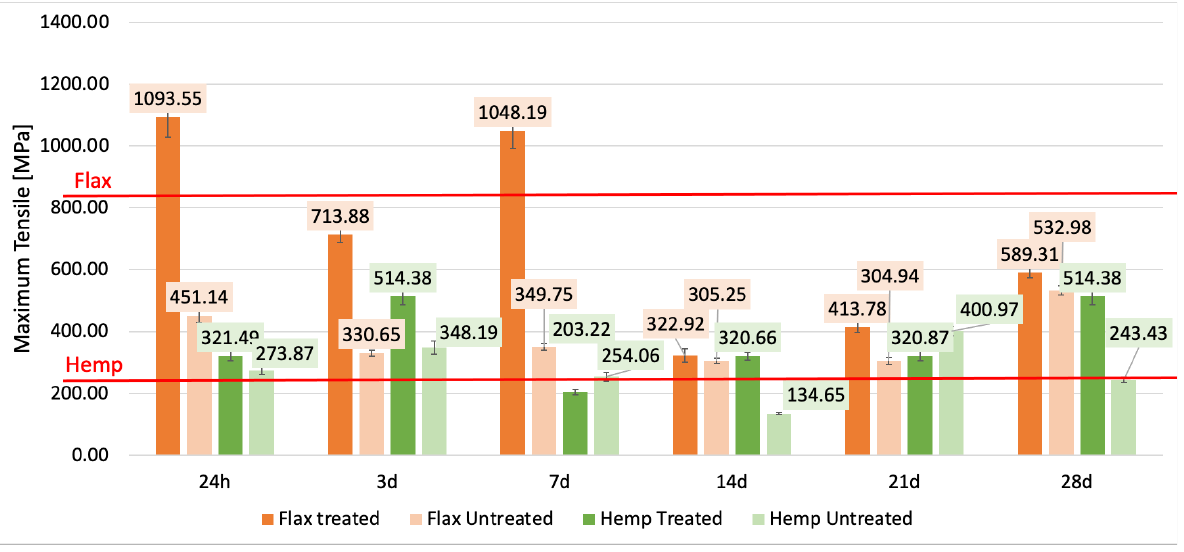
Figure 14. Effects of the degradation at an alkaline solution on the elastic modulus. For hemp fibres, no pattern could be found for enhancement of the tensile strength through time (non-linear behaviour), but compared to the strength of natural untreated hemp fibres, after 28 days of degradation, the treated fibres were 95% stronger than the untreated natural fibres from Table 3. Untreated fibres reduced their tensile strength by 8.4%. In terms of the elastic modulus, untreated flax fibres did not change significantly during the experiment, with E reduced from 40.78 GPa to values from 25.2 to 28.8 GPa. However, treated and degraded flax fibres had their elastic modulus increased in the first 24 h, gradually decreased during the first two weeks, and higher again during the final 14 days of the experiment, which could indicate an increase in their stiffness through time. For treated hemp fibres, the variability of the elastic modulus was smaller in compar- ison to flax. Results indicate that treated fibres presented increased elastic modulus after 3 and 28 days of the experiment, while degraded untreated fibres presented lower elastic modulus throughout the test except for the samples tested at 21 days. These results could